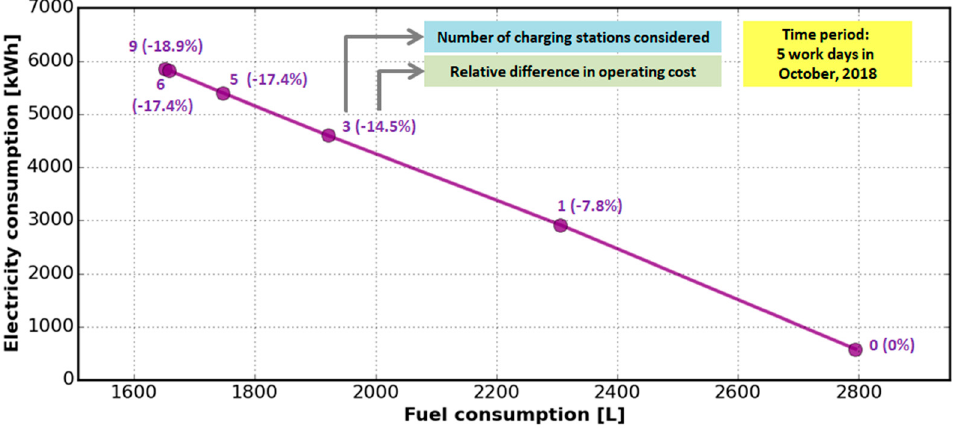
Figure 15. Pareto frontier-like plot showing PHEV bus fleet electricity vs. fuel consumption costs for different number of end stations equipped with a fast charger per station.